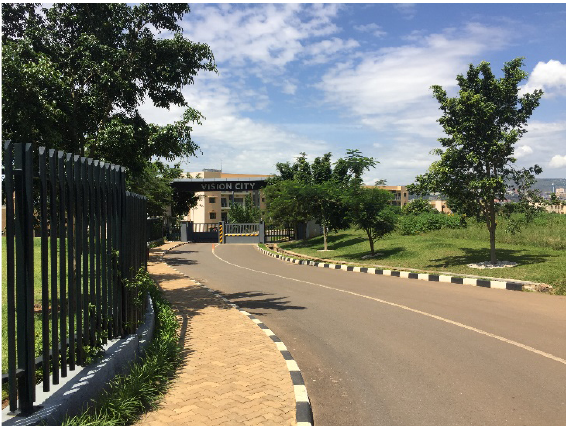
Figure 47. The narrow central green area, west views Photograph by Manlio Michieletto.